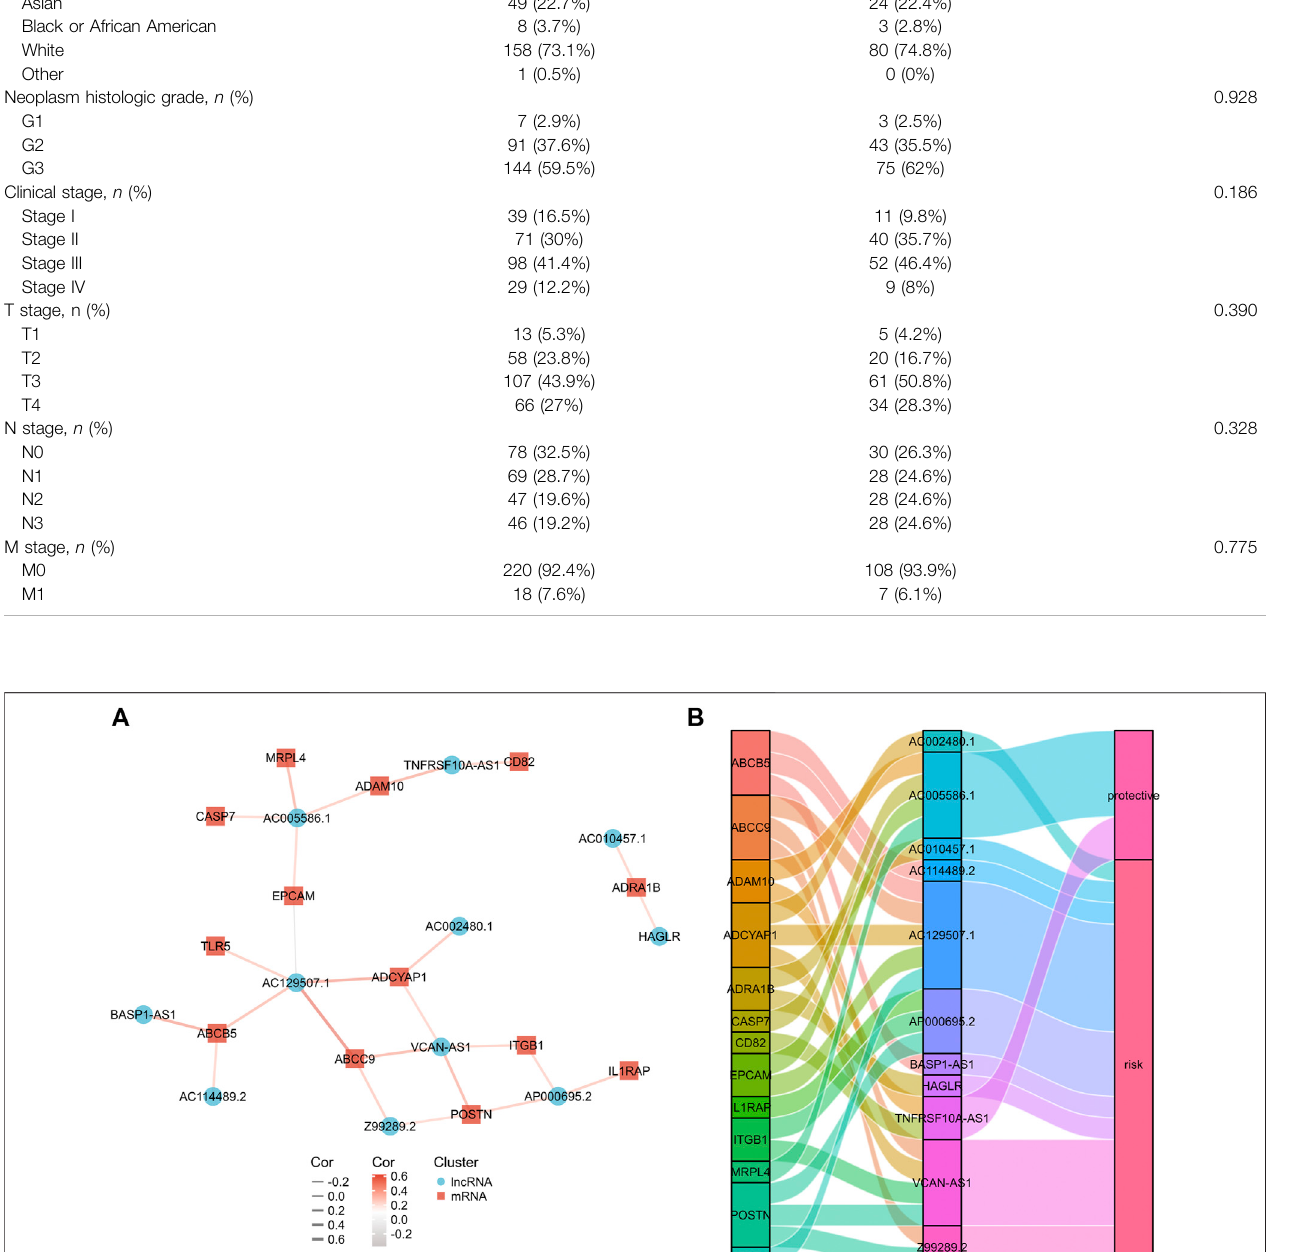
Frontiers in Cell and Developmental Biology |